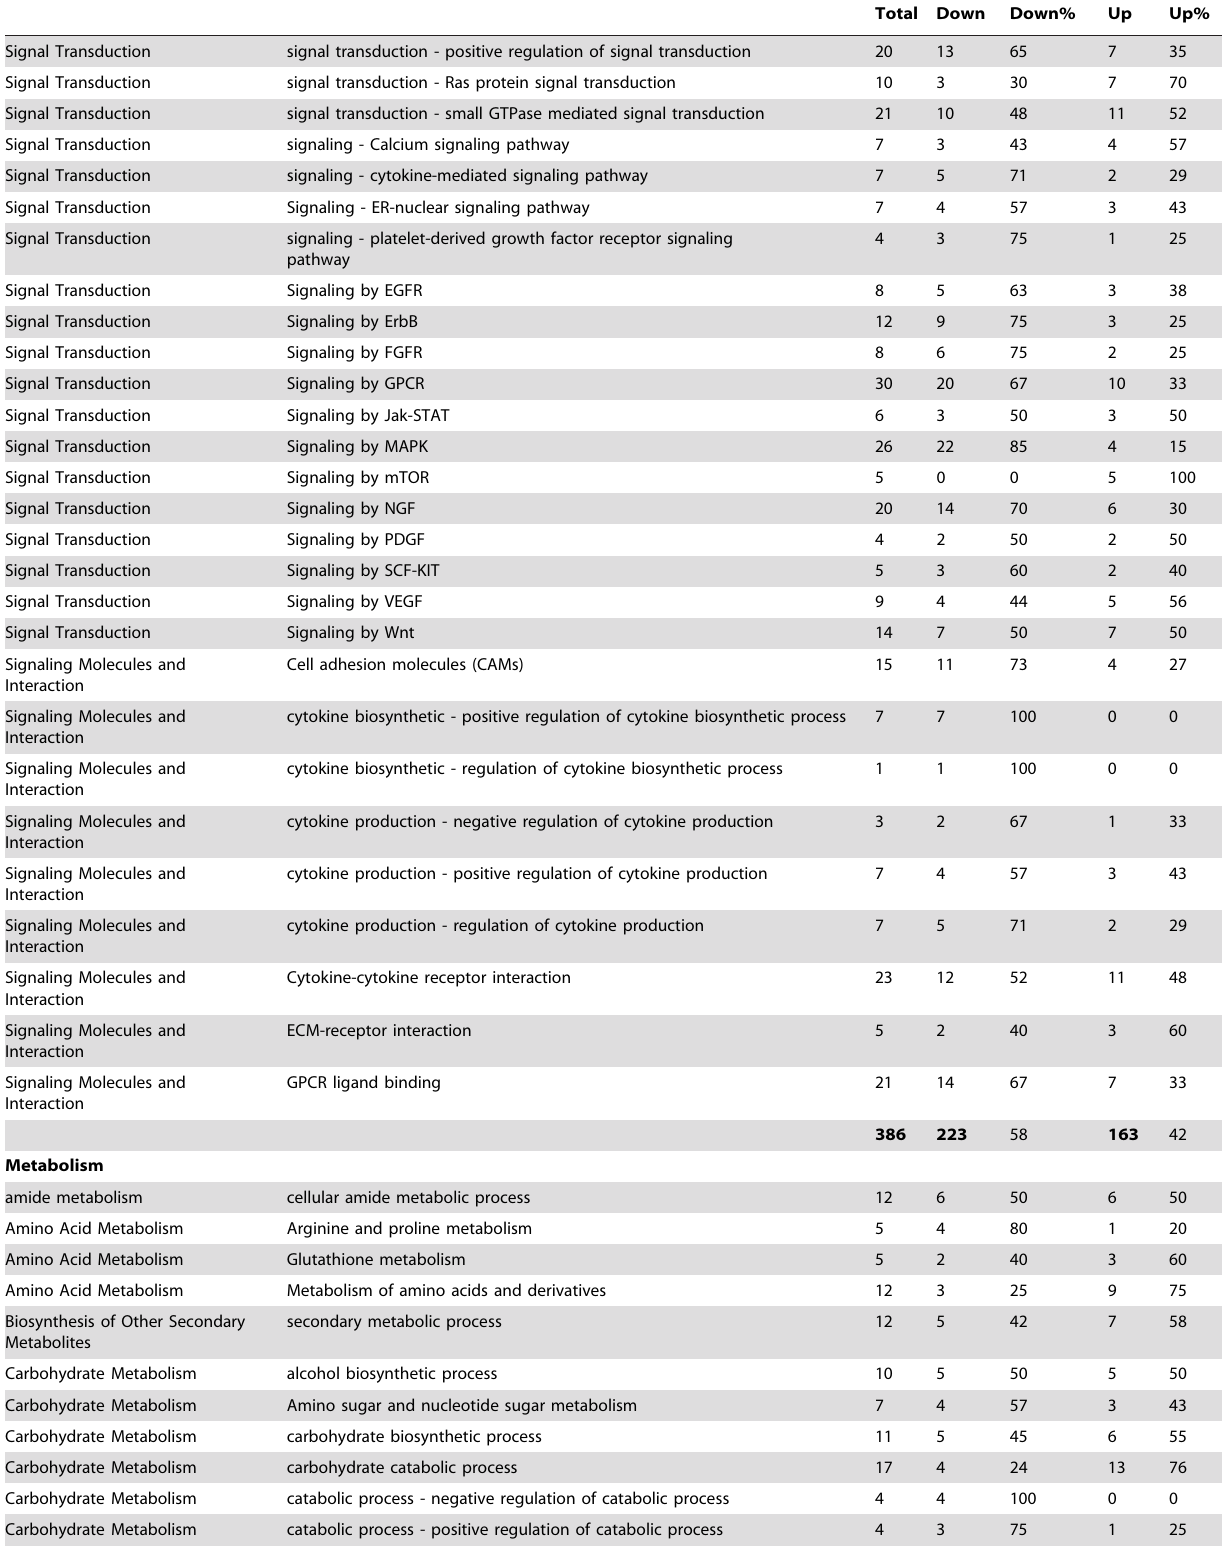
Total Down Down% Up